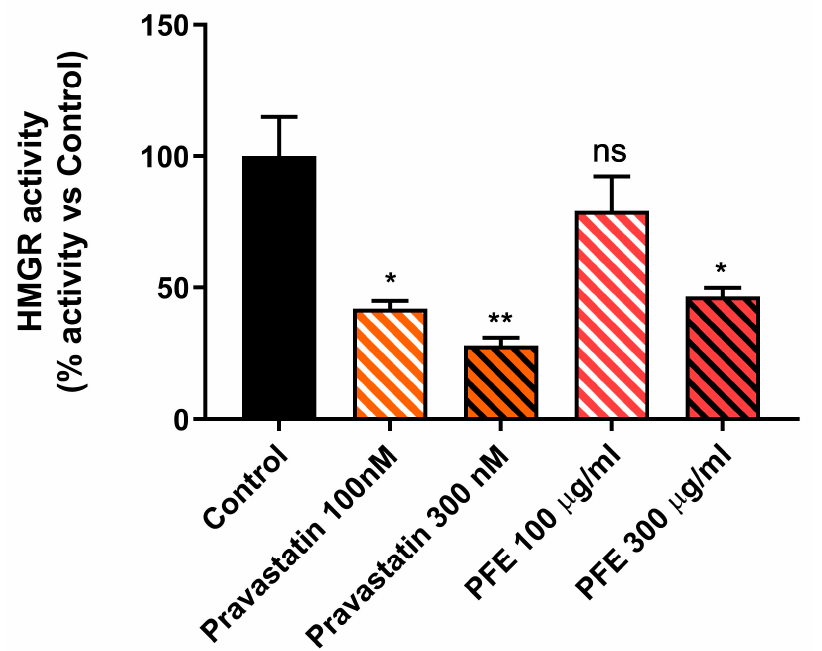
Figure 2. Picrocrocin inhibits the activity of the purified HMGR catalytic subunit. Results are ex- pressed as percentage of enzymatic activity versus control (enzymatic assay without inhibitors); pravastatin was used as a positive control. Values represent mean ± SD of three independent exper- iments. * p value < 0.05; ** p value < 0.01; ns: